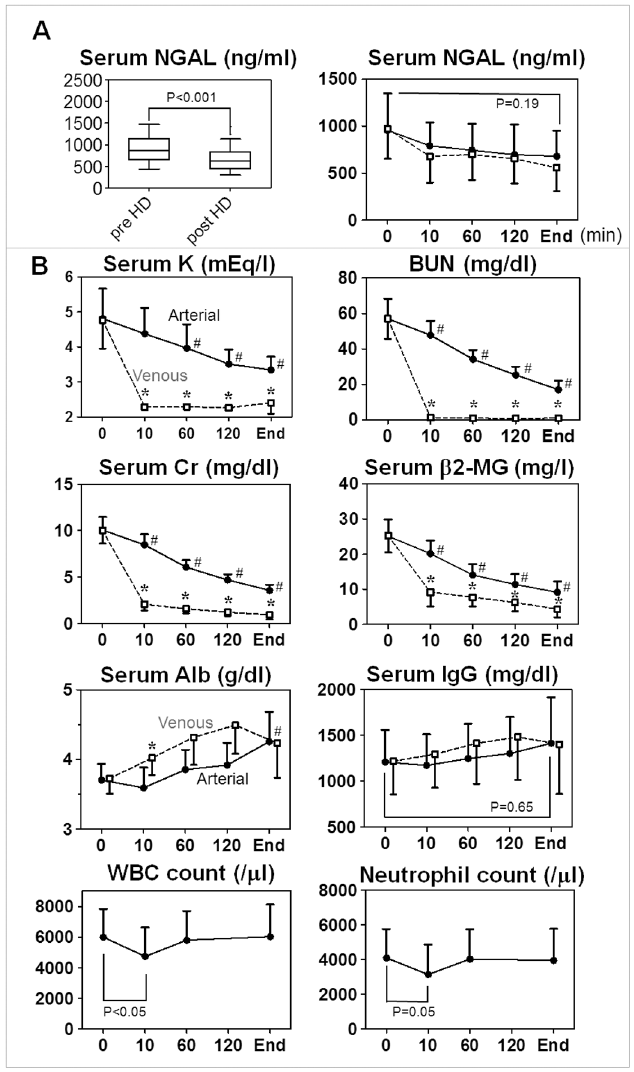
Fig 4. Removal of circulating substances by HD session. Blood was serially drawn from the arterial and venous ends of HD circuit (closed circle and open box, respectively) during HD session. End points varied from 3.0 to 4.5 h. Mean ± SD. ( A ) Comparison of arterial blood NGAL levels between before and after HD session (left, n = 139). Time course of arterial and venous NGAL levels are also shown (right, n = 9). ( B ) Serum levels of K, BUN, creatinine (Cr), β 2-microglobulin (MG), albumin (Alb) and IgG, as well as blood WBC and neutrophil counts are shown (n = 9). Arterial levels of K, BUN, Cr, β 2-MG were always higher than venous levels, indicating active removal by HD. On the other hand, venous levels of albumin and IgG tended to be higher than arterial levels, reflecting hemoconcentration by HD. # P < 0.05, significant difference from time 0 by repeated-measures ANOVA. * P < 0.05, significant difference between arterial and venous blood. (sepsis), Pseudomonas aeruginosa (pneumonia) and Streptococcus aureus (lower extremity gan- grene). In subjects with the lowest NGAL tertile, odds ratio (OR) [95% confidence interval] for development of severe infection requiring admission was 3.1 [0.6 – 15.0] compared to the mid- dle and highest tertiles, but it did not reach statistical significance (S9 Table). Presence of diabe- tes mellitus also showed a tendency to be associated with increased occurrence of severe infection, but again not significantly (S9 Table). On the other hand, OR for admission due to